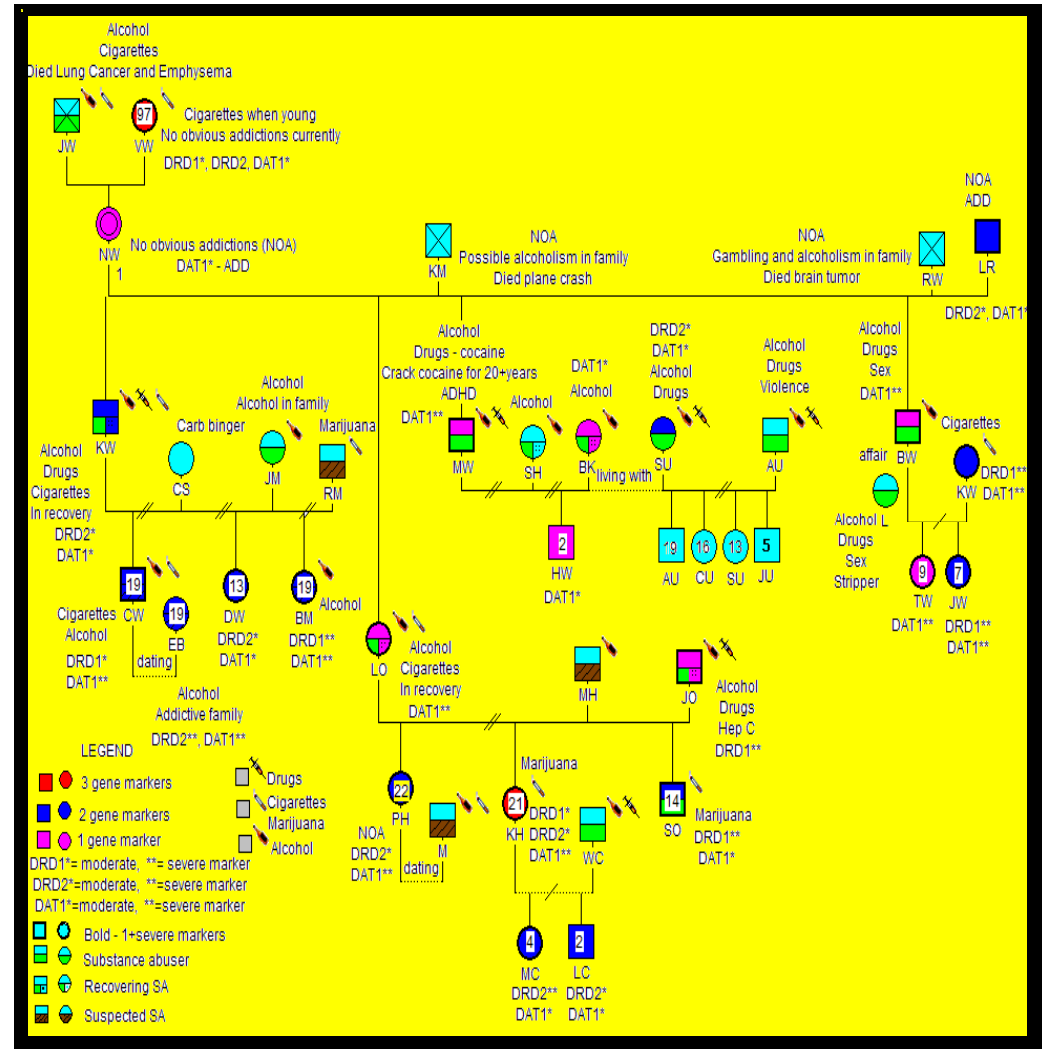
Figure 2. Association of dopaminergic gene polymorphisms with RDS behaviors in Family B (n =